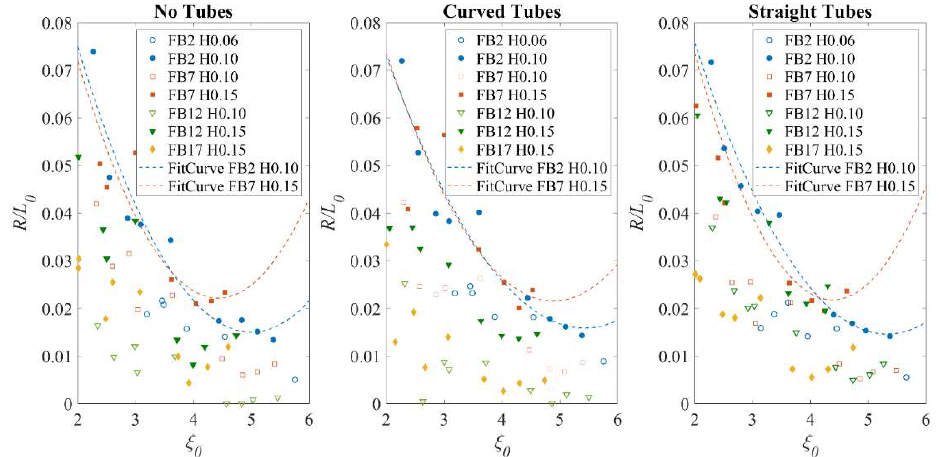
Figure 10. Relationship between wave lengths normalized run-up and Iribarren number for different tube designs, (freeboard heights are in cm in the legends).